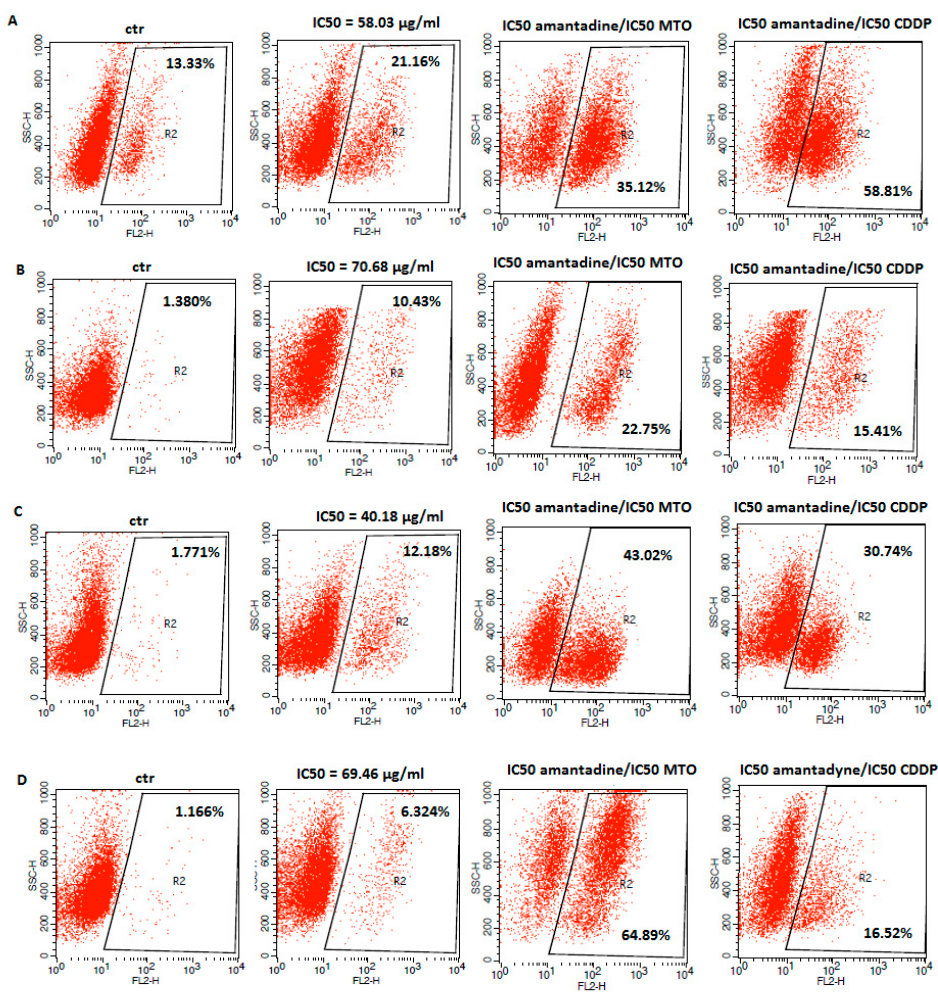
Figure 4. Representative flow cytometry dot plot graphs of A375 ( A ), SK-MEL28 ( B ), FM55P ( C ) and FM55M2 ( D ) melanoma cell lines after the treatment with a medium (ctr) and amantadine alone or in combination with CDDP and MTO at their IC 50 concentrations for 72 h. Region R2 included apoptotic cells with active caspase-3.